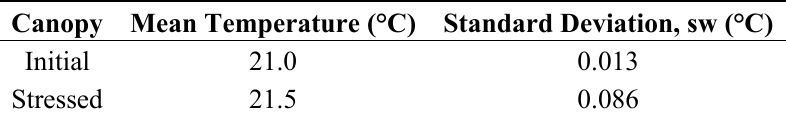
Table 4. Dependence of temperature variability on soil moisture.